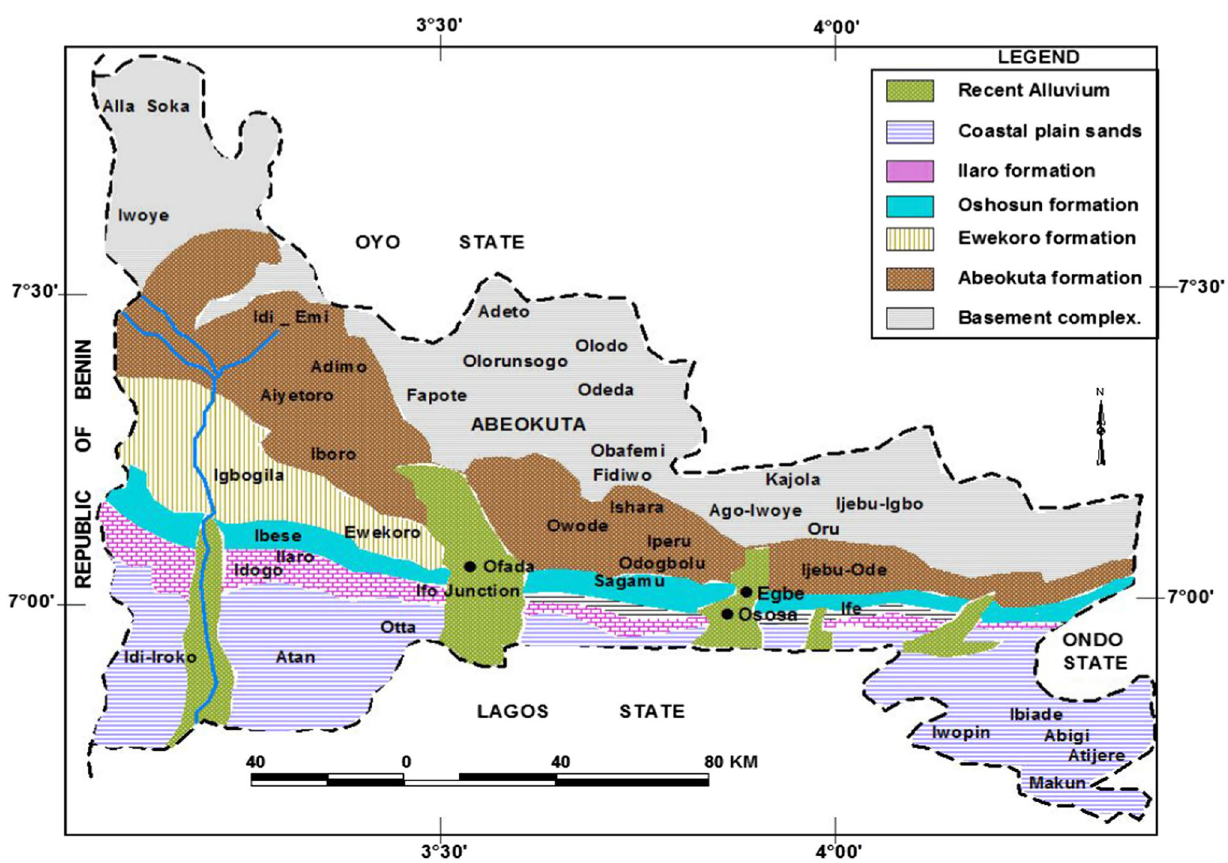
Fig. 1 Geological Map of Ogun State showing Ilaro